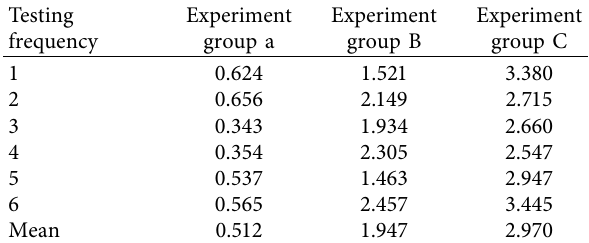
Table 2: Surface relative accuracy error (mm 2